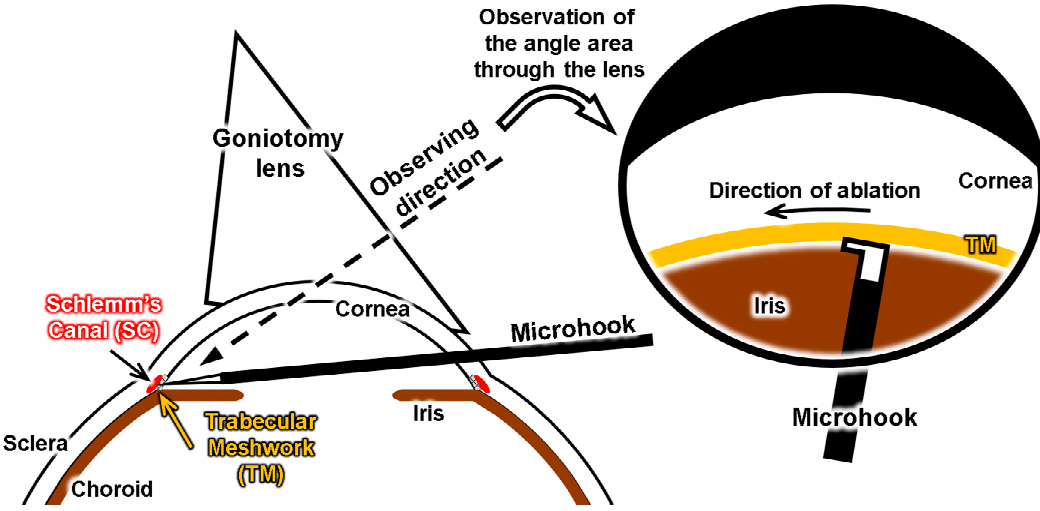
Figure 2. Concept of a glaucoma model for training on inside-out (ab interno) surgery.